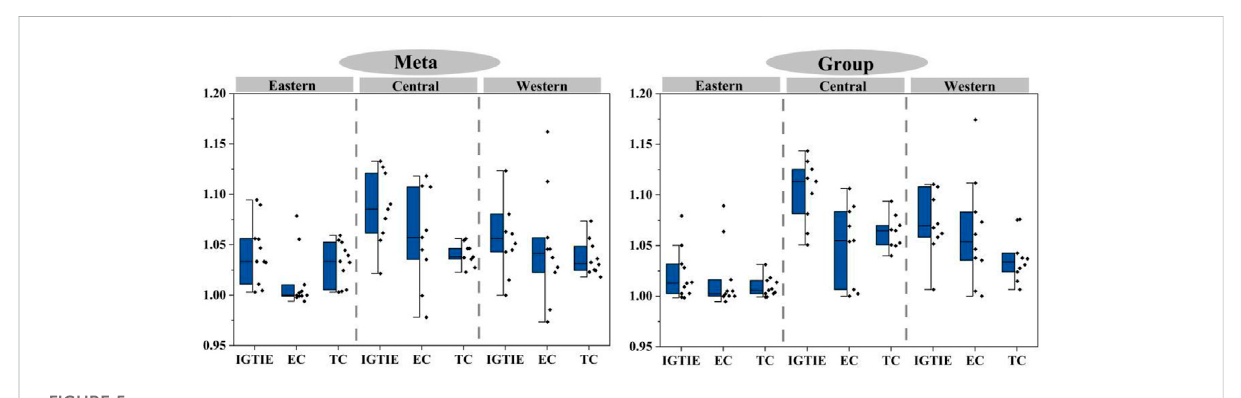
FIGURE 5 Average IGTIE and its decomposition target in three